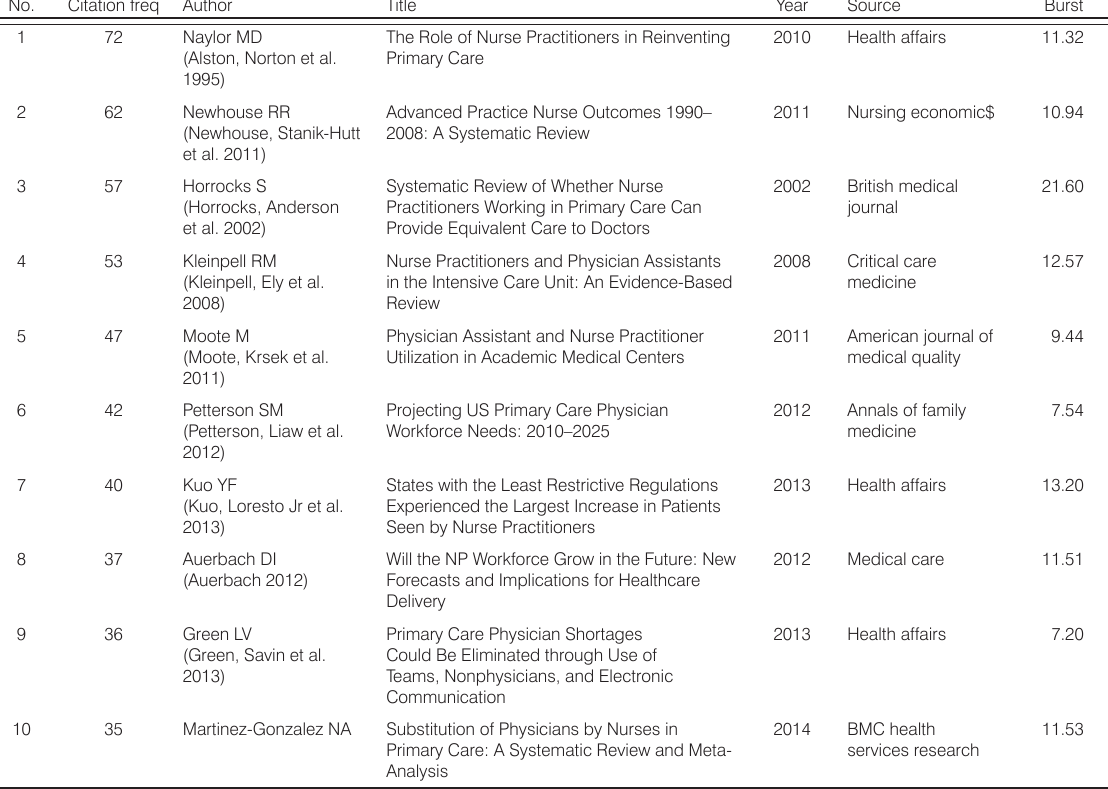
Table 7. The top 10 co-cited references in NPs according to the citation